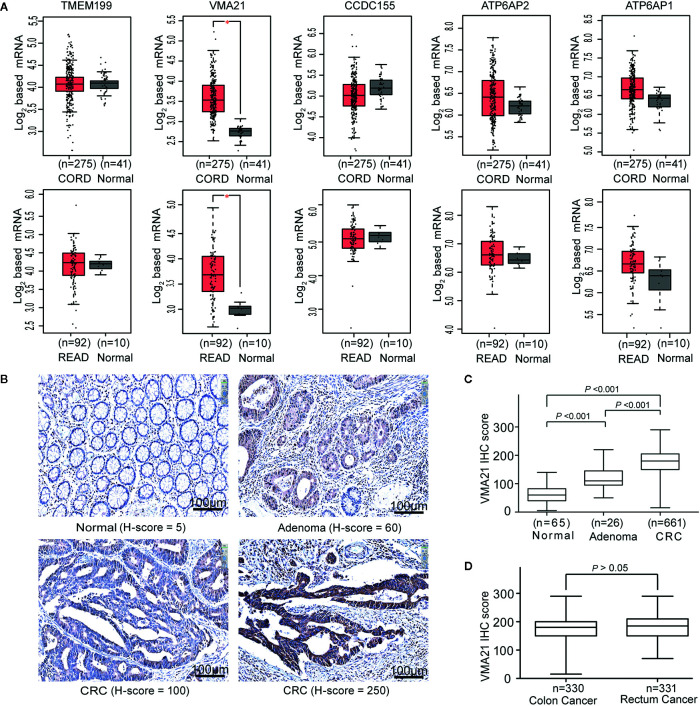
VMA21 is elevated in colorectal cancer. (A) Expression patterns of five assembly factor genes of the V0 domain of V-ATPase based on TCGA-CRC mRNA data. (B) Immunostaining of VMA21 in CRC and noncancerous tissues. (C) VMA21 protein expression in normal, adenoma, and CRC tissue specimens. (D) Expression pattern of the VMA21 protein in colon cancer and rectal cancer. CORD, colon cancer; READ, rectum cancer.